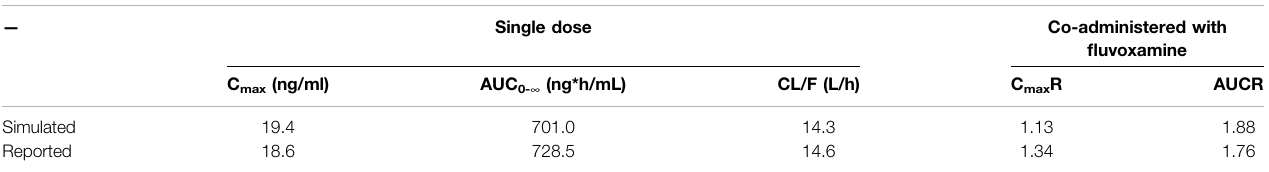
fl uvoxamine AUCR